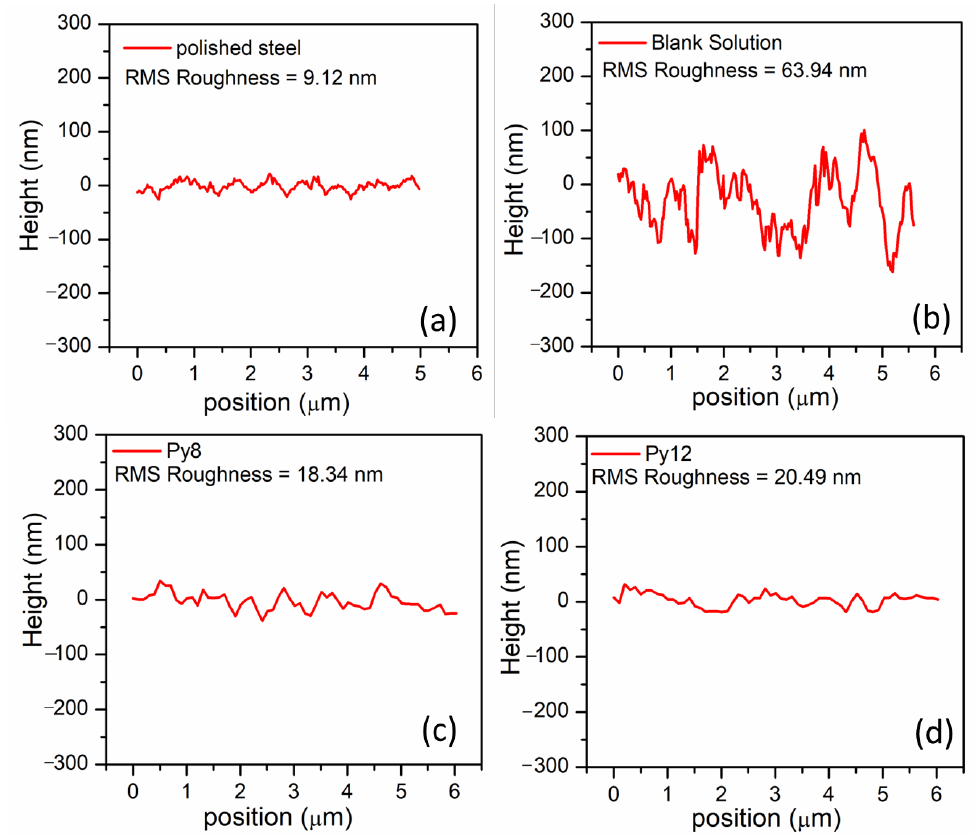
Figure 11. Height profiles obtained from AFM images of EN3B mild steel ( a ) Polished ( b ) Immersed in 3.5% NaCl, pH = 1.5 without inhibitor ( c ) In the presence of 10 mM Py8 and ( d ) 10 mM Py12.